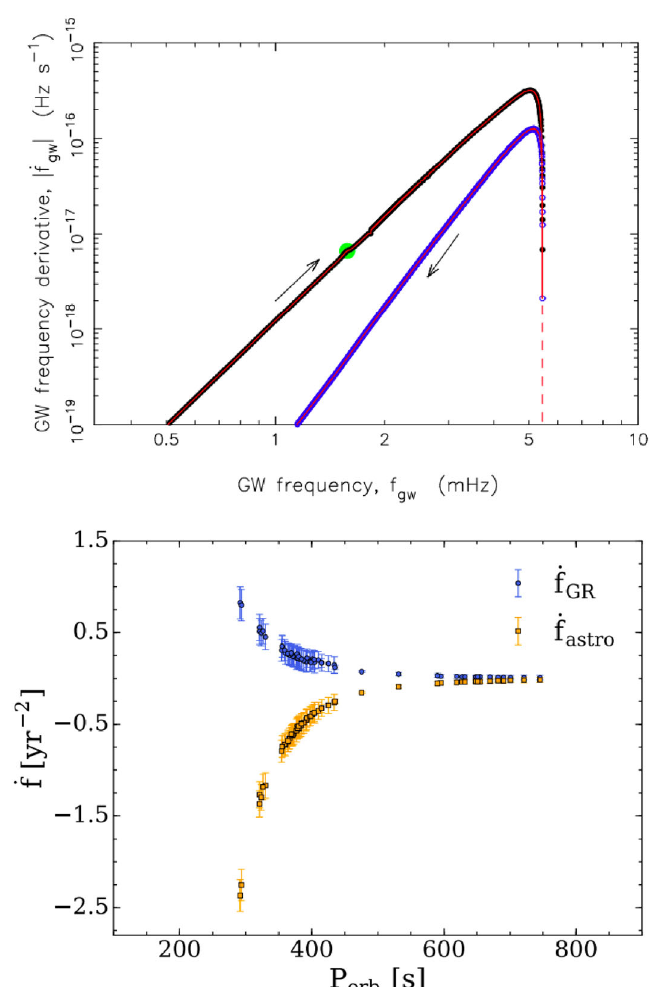
Fig. 12 Upper panel: GW frequency derivative, j _ f GW j as a function of GW frequency, f GW for the UCXB shown in Figs. 4 and 5. The black coloured points correspond to the inbound leg (orbital shrinking) and the blue points correspond to the outbound leg (orbital expansion, after reaching the orbital period minimum) including mass transfer/loss from the system and fi nite-temperature effects of the WD donor. Each point represents a binary stellar MESA model. The green solid circle indicates the onset of the UCXB stage. (Before this point, the system is a detached NS ? WD binary). Bottom panel: pure general relativistic (GR, blue) and astrophysical (orange) chirps as a function of GW frequency for WD ? WD (AM CVn) systems. The astrophysical contribution from mass transfer and tides leads to a signi fi cant deviation from the contribution from GR alone and will cause the systems to widen their orbit upon mass transfer. The decoupling of the astrophysical chirp from the GR chirp will be possible with combined measurements from LISA and Gaia. The error bars show the anticipated 1 r measurement errors. On average, Breivik et al. (2018) fi nd that about 50 AM CVn systems in the Mikly Way with P orb \ 800 s have resolvable GR and astrophysically driven chirps. Images reproduced with permission from [top] Tauris (2018), copyright by APS; and [bottom] Breivik et al. (2018), copyright by